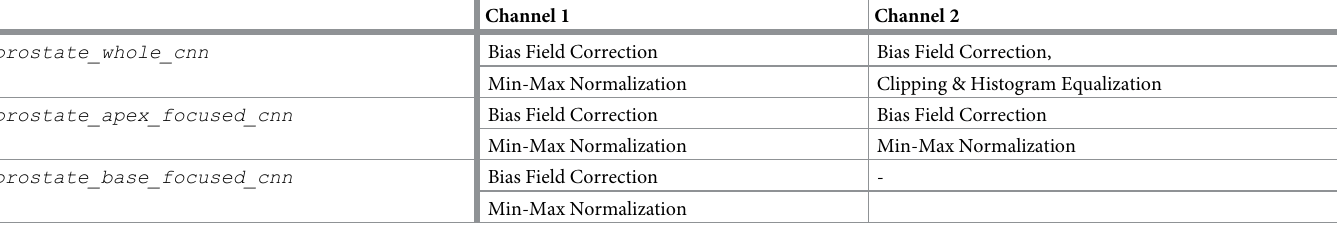
Table 1. Image preprocessing steps selected by the KNoLO optimizer for each DNN input channel for the three prostate